Question: Identify the chart type used in this figure.
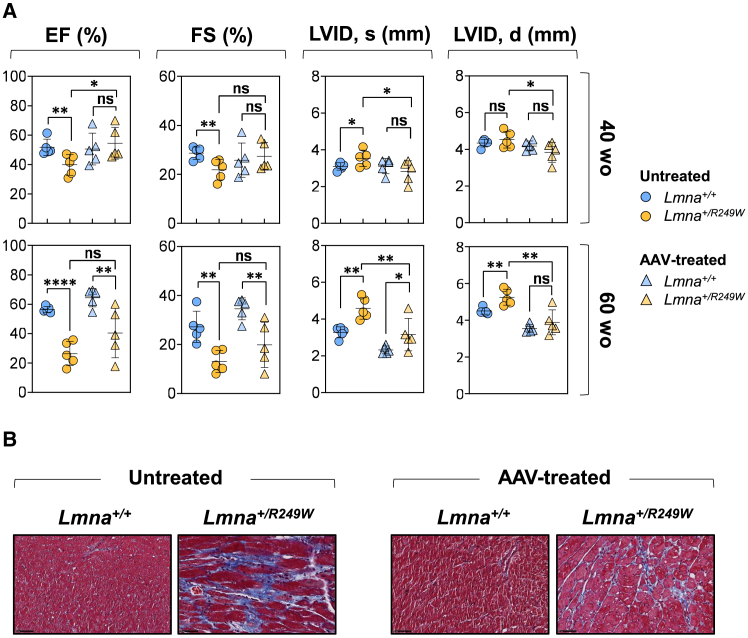
Answer: bar